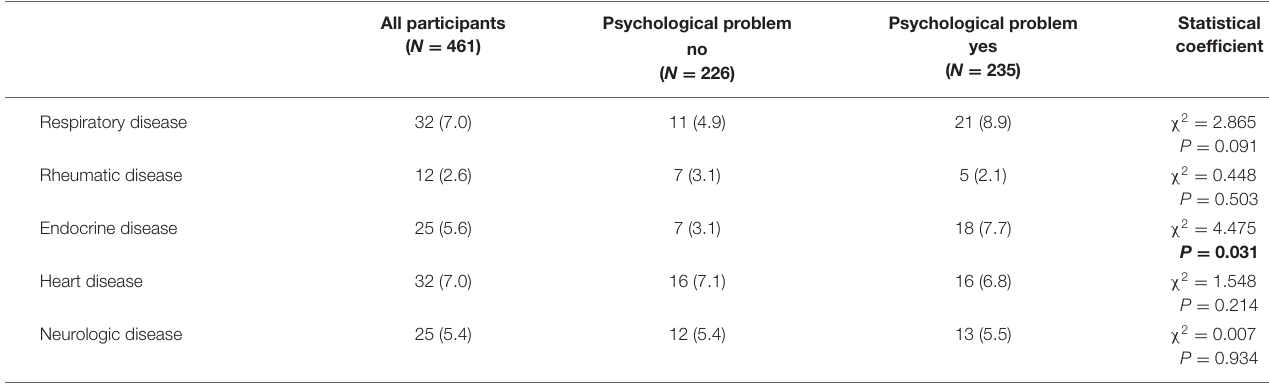
TABLE 2 | Comparison of anxiety depression insomnia suicidal ideation among patients with/without COVID-19 symptoms.